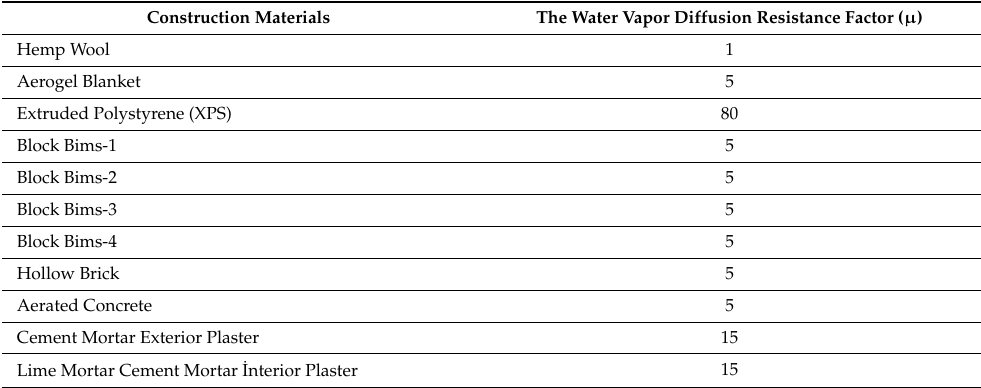
Table 5. The water vapor diffusion resistance factor of construction materials